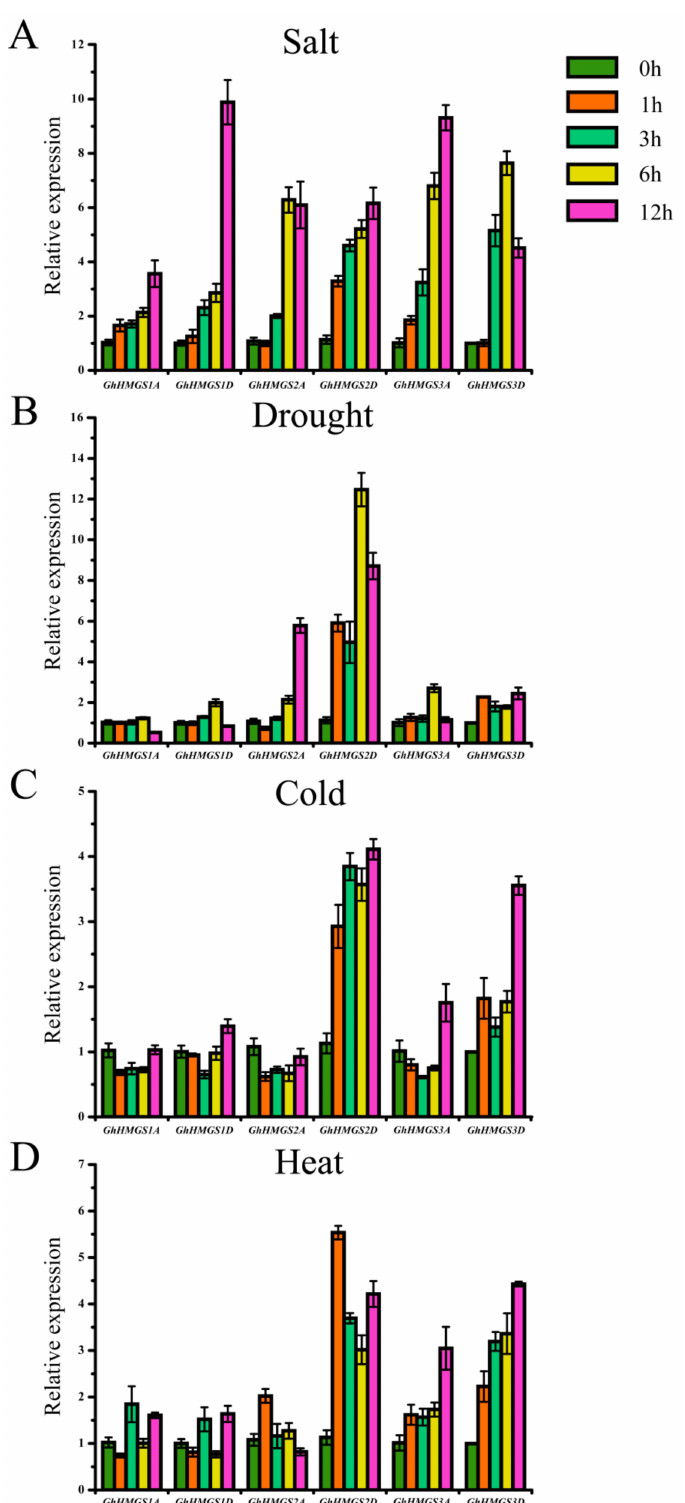
Figure 6. Expression analysis of G. hirsutum HMGS genes under abiotic stresses: ( A ) salt; ( B ) drought; ( C ) cold; ( D ) heat. The relative expression levels of GhHMGS genes under di ff erent abiotic stresses were calculated with the cotton UBQ7 gene as an internal control. Error bars represent the standard deviations estimated from three independent